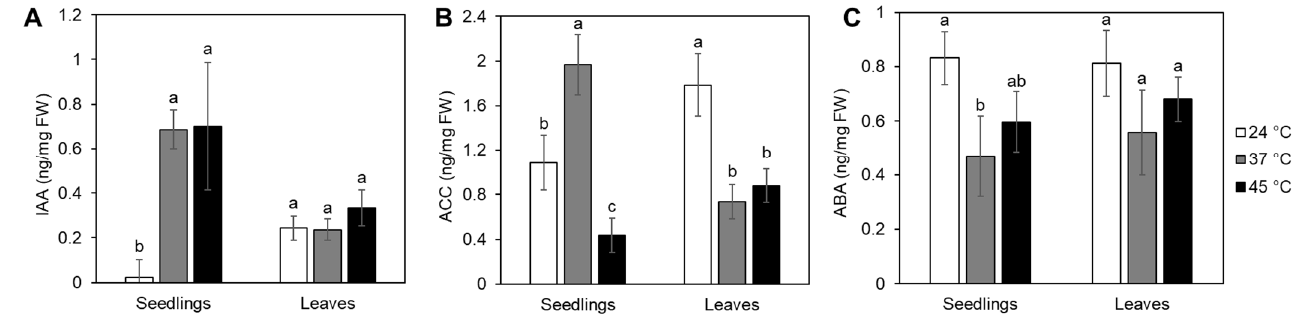
Figure 4. Phytohormone levels in tomato seedlings and adult plant leaves. Seedlings or adult plants were treated either continuously at 37 °C or 45 °C followed by recovery. Control plants were kept at 24 °C (Figure S1C,D). ( A ) Indol-3-acetic acid (IAA), ( B ) 1-aminocyclopropane-1-carboxylic acid (ACC) and ( C ) abscisic acid (ABA) were measured from whole seedlings or leaves harvested 24 h from the start of the treatments and expressed per fresh weight (FW). Each biological replicate consisted of 15 seedlings or leaves pooled from 6 adult plants. Data represent the average of 3 replicates with standard deviations denoted by vertical bars. Different letters indicate a significant difference between control and heat treatments at p < 0.05 (Tukey’s test) for each tissue type separately.